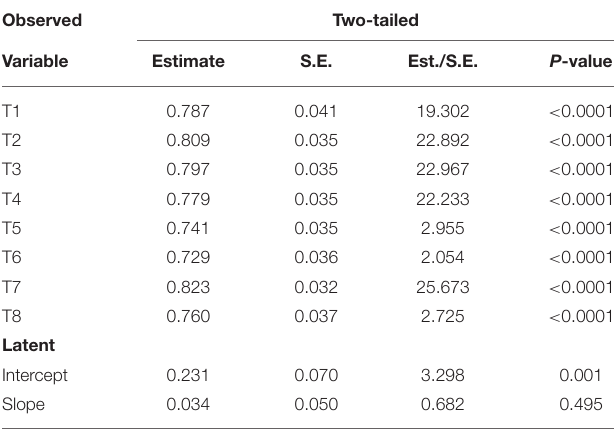
TABLE 3 | Observed and latent R 2 of PHQ-4 values at each measurement time point (T1-8). Observed Two-tailed